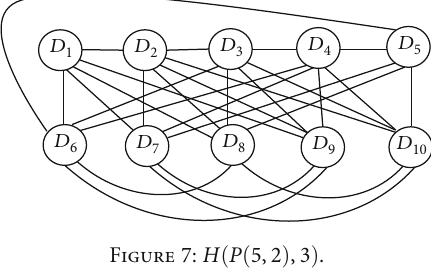
Figure 7: H ð P ð 5, 2 Þ , 3 Þ